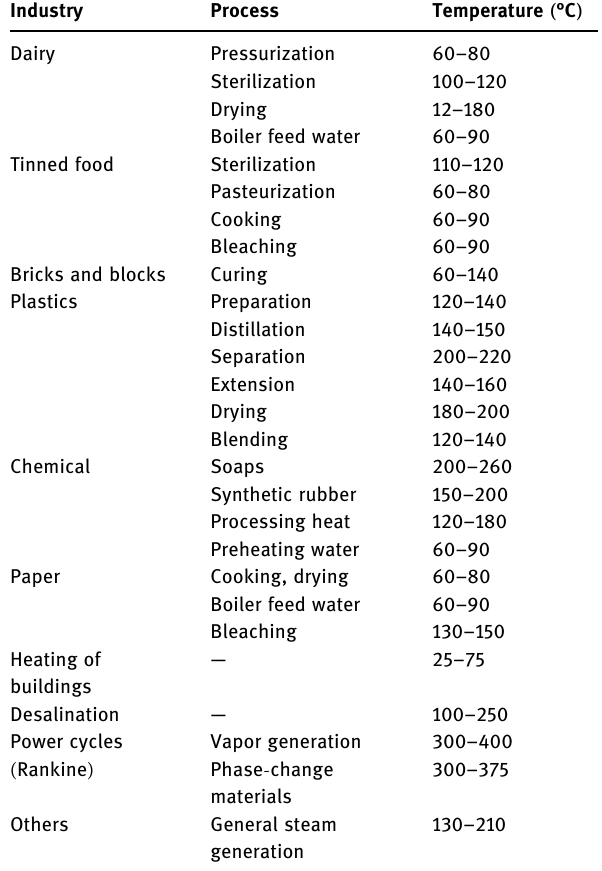
Table 8: Temperature range for industrial processes [ 97,102,104,107 ]